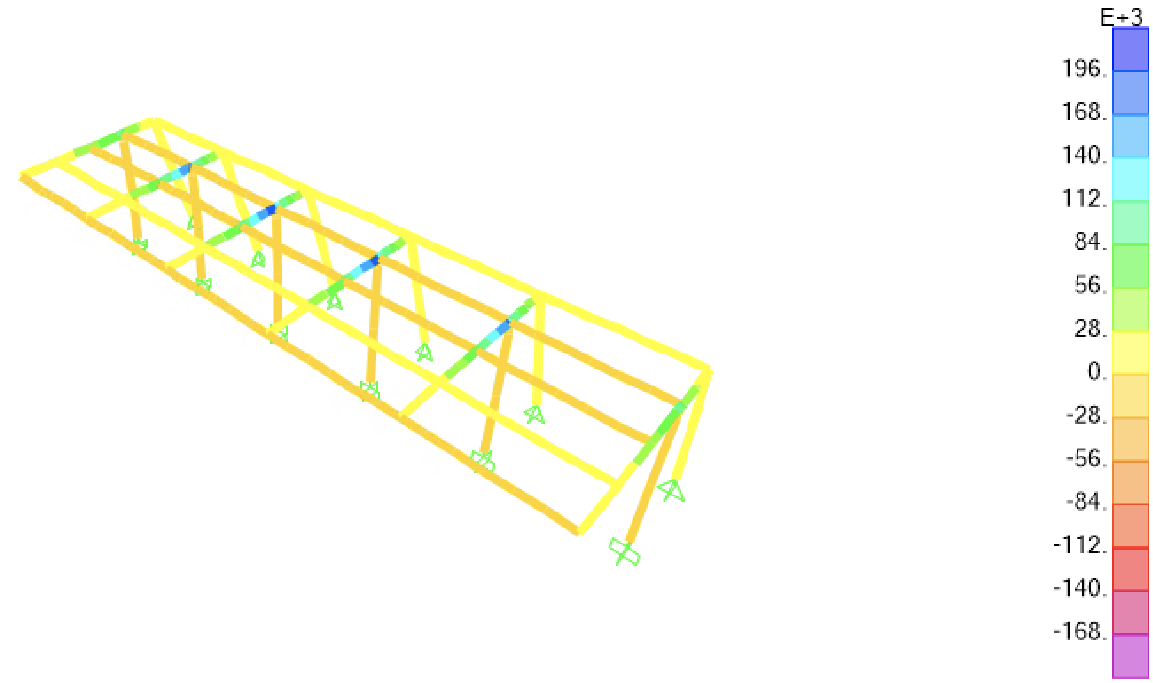
Figure A14. Cantilevered system stress contour in kPa using finite element analysis.